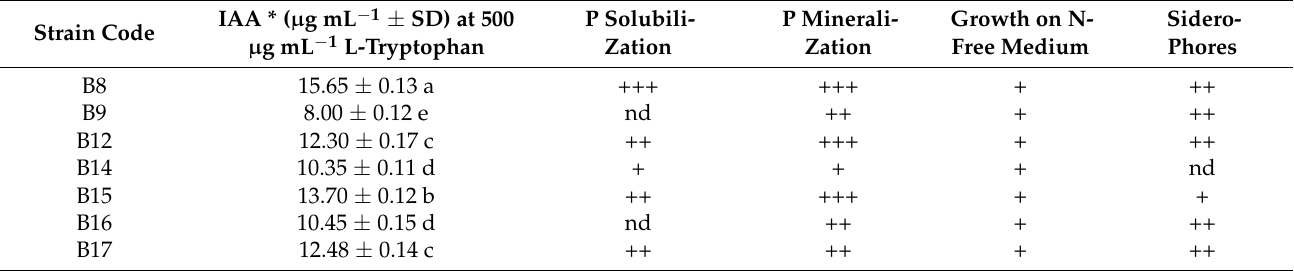
Table 2. Plant growth-promoting properties of Bacillus megaterium